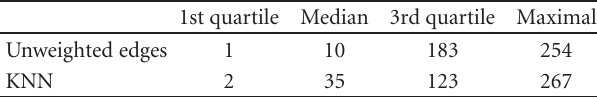
Table 3: Quartile, median and maximal values of the number of communities a user belongs to, on the MovieLens